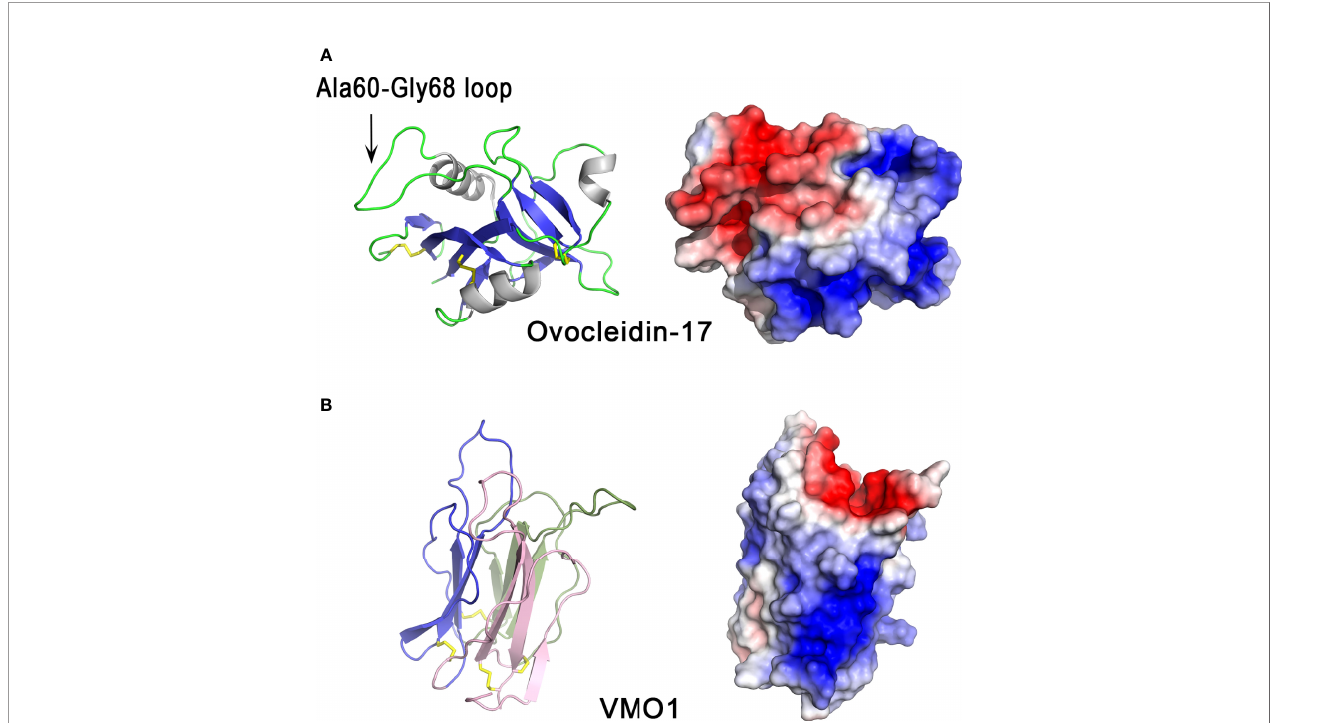
FIGURE 2 | 3D structures of eggshell lectin-like proteins, ovocleidin-17 and VMO1. 3D structure of chicken ovocleidin-17 (A) and chicken VMO1 (B). The left panels correspond to the cartoon representation of 3D structure while the right panels show the color-coded electrostatic potential molecular surface. Color scheme ranges from red (negatively charged regions) to deep blue (positively charged regions). The Ala60-Gly68 exposed loop of ovocleidin-17 containing the two phosphorylatable serine residues (Ser61 and Ser67) is indicated. The fi gure was prepared using Pymol software (48) and APBS (Adaptive Poisson-Boltzmann Solver) plugin (49) for electrostatic calculations using atomic coordinates of 1GZ2 and 1VMO PDB fi les (www.rcsb.org) for OC-17 and VMO1,